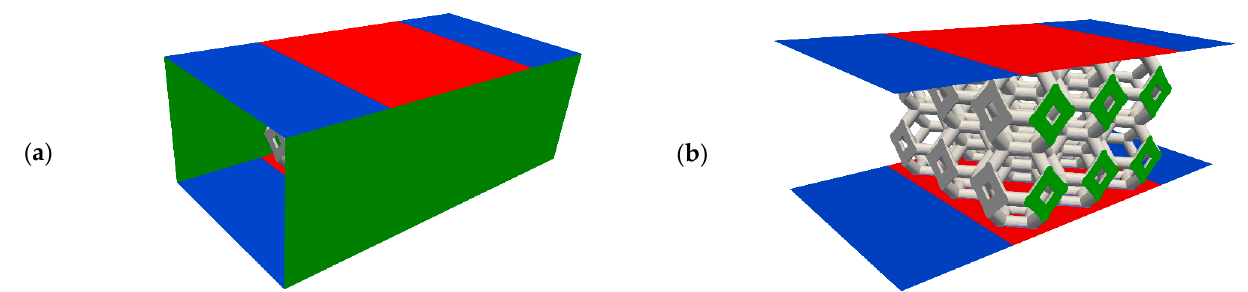
Figure 3. Example of computational domain: picture ( a ) shows the box surrounding the lattice. Picture ( b ) shows the same box without the lateral boundaries. The different boundary conditions are represented with different colours: blue patches are adiabatic no-slip walls. Green patches are cyclic and red patched are fixed temperature no-slip walls. Depending on the setup, the lattice surface (in grey) can be a fixed temperature wall or the interface between the fluid region and the solid one. The inlet and outlet patches are missing in both images for clarity.